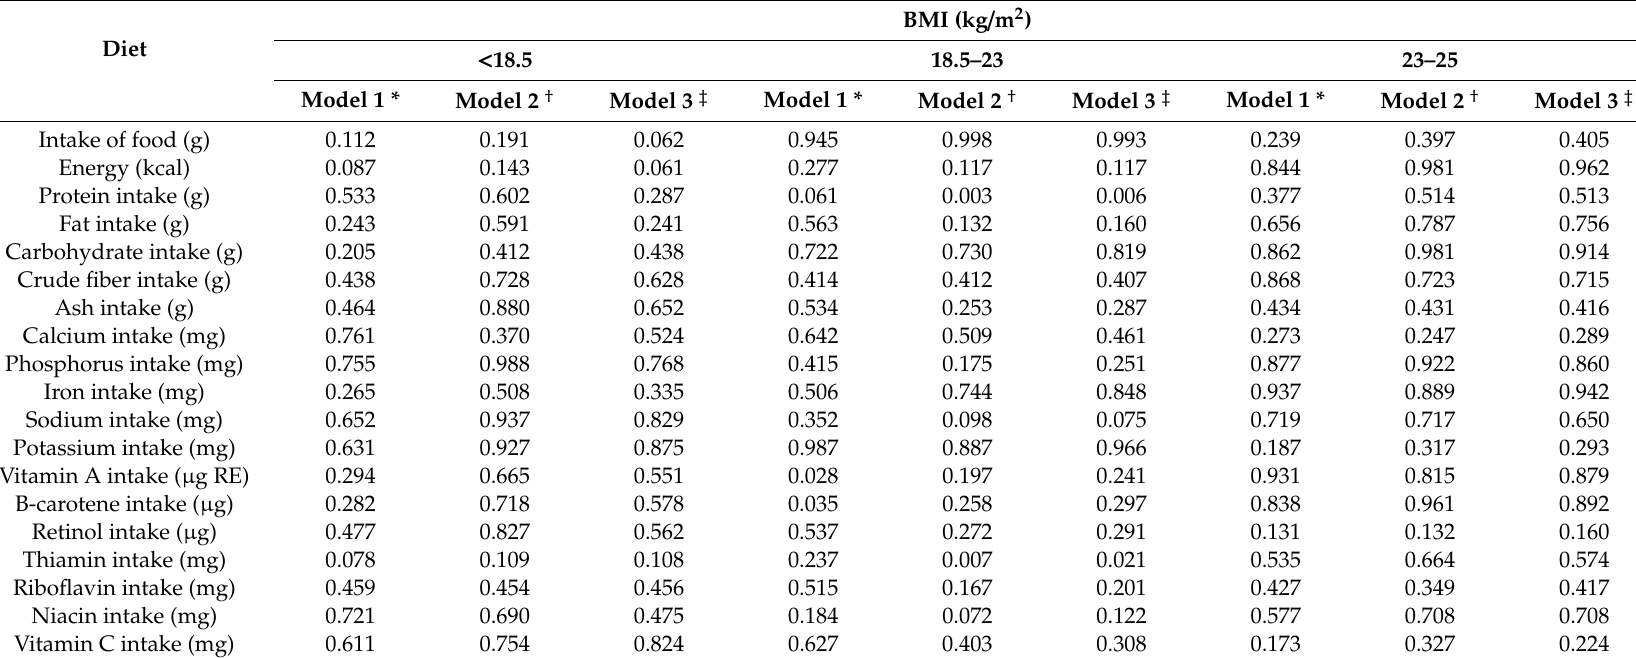
Table 4. Dietary intake between primary open angle glaucoma (POAG) and non-glaucoma group in males grouped by